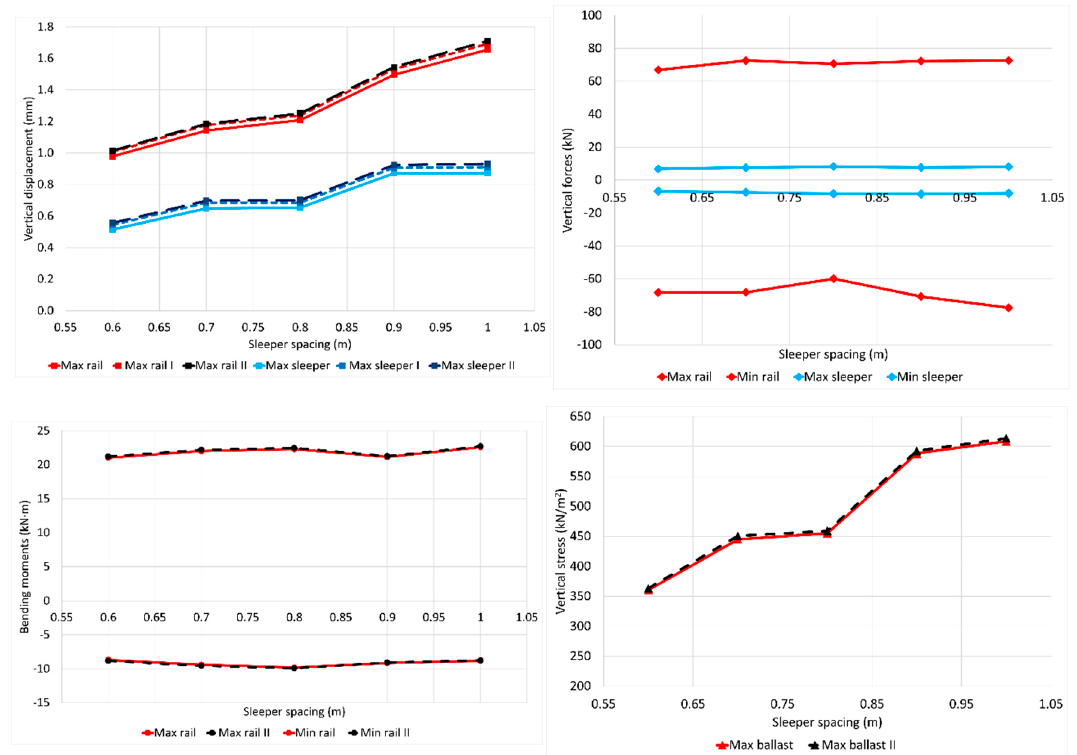
Figure 8. Case 6. Maximum vertical displacements of the rail and sleeper, shear forces on rail and sleeper, rail bending moments, and stresses on ballast.